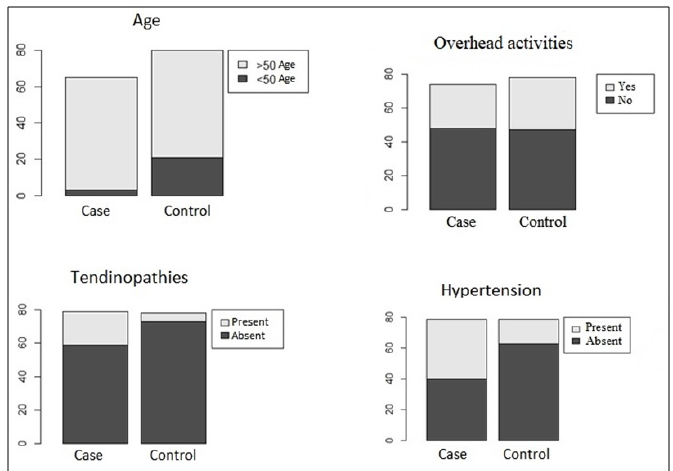
Figure 1. Distribution of clinical-epidemiological variables that where statistically significant with the variable “overhead activities”. Table 3. Distributions of allelic frequencies of rs820218 of the SAP30BP gene in the populations. Allele (rs820218)